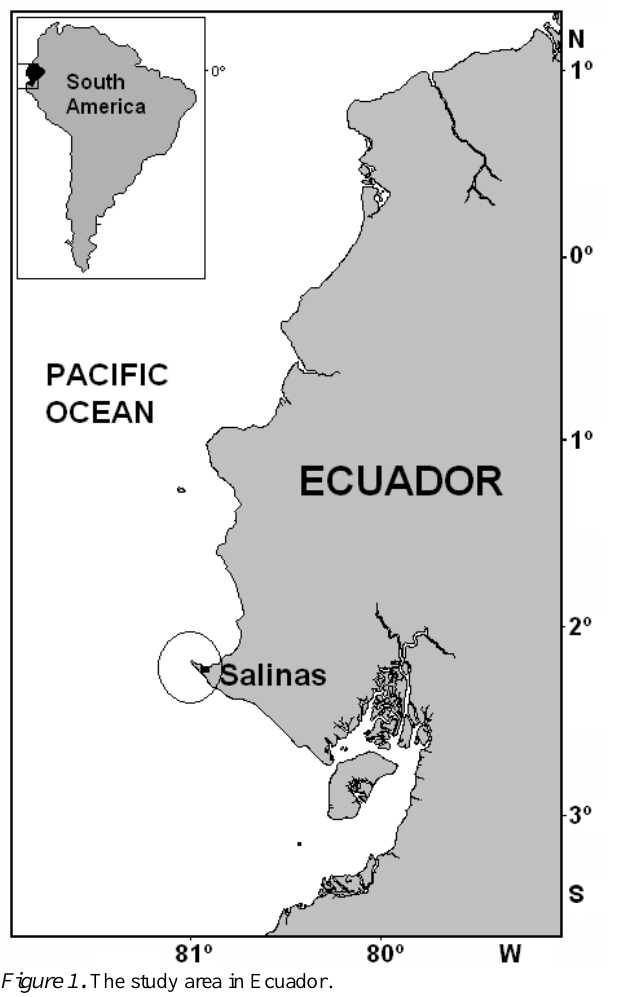
Figure 1. The study area in